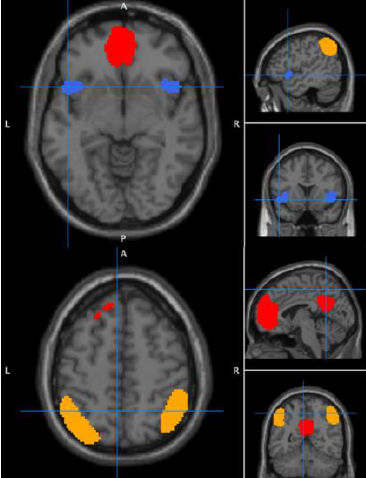
Table 1. Coordinates and volume for the included regions of interest.